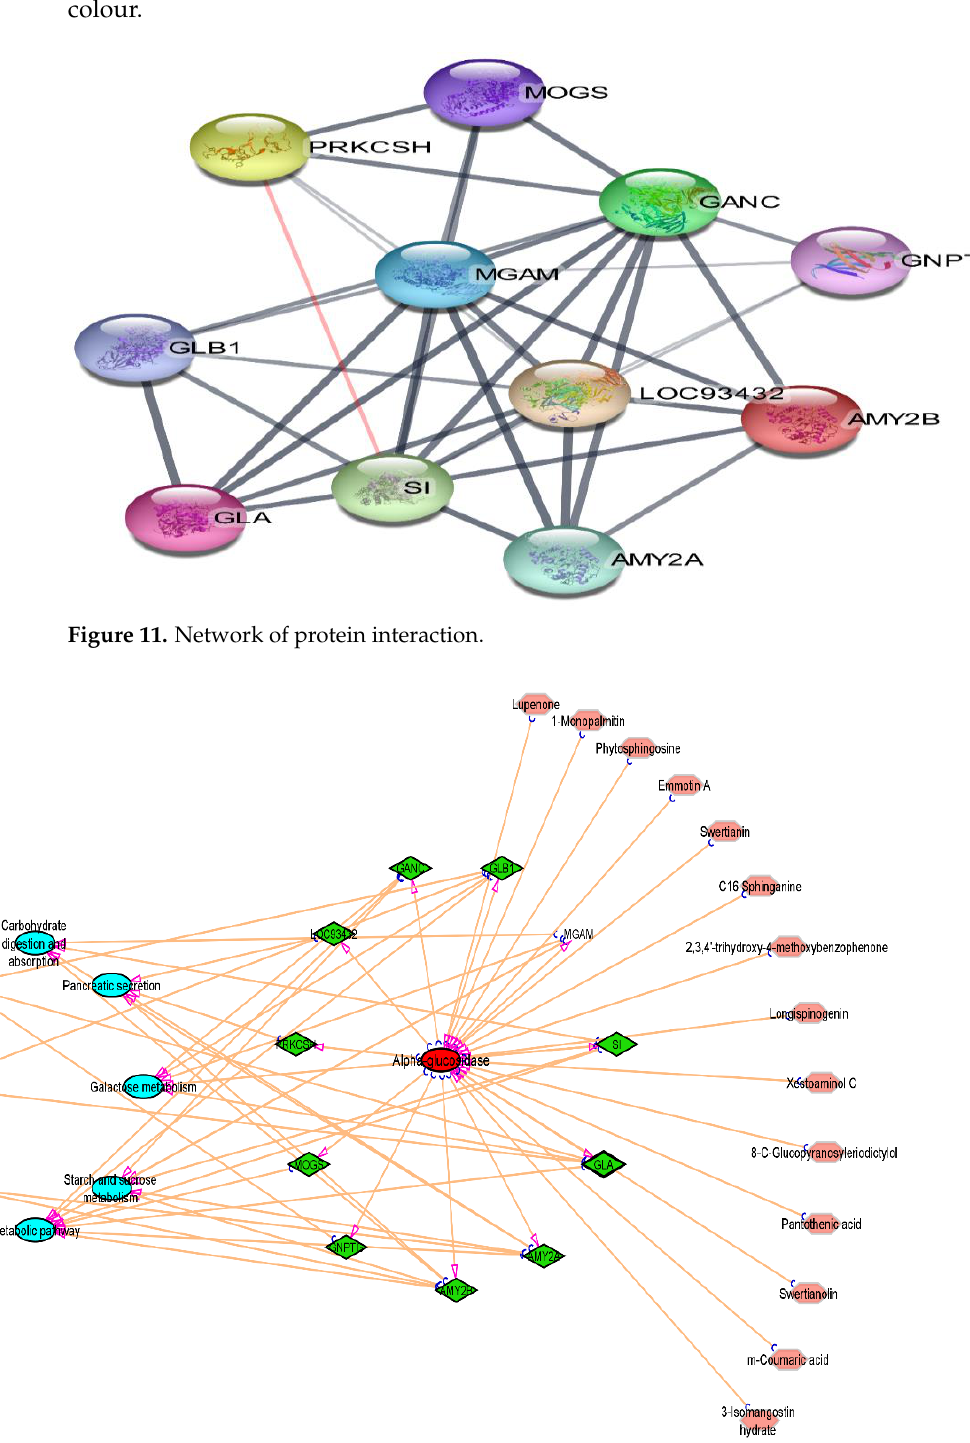
Figure 12. Compound-Target-Pathway Network.